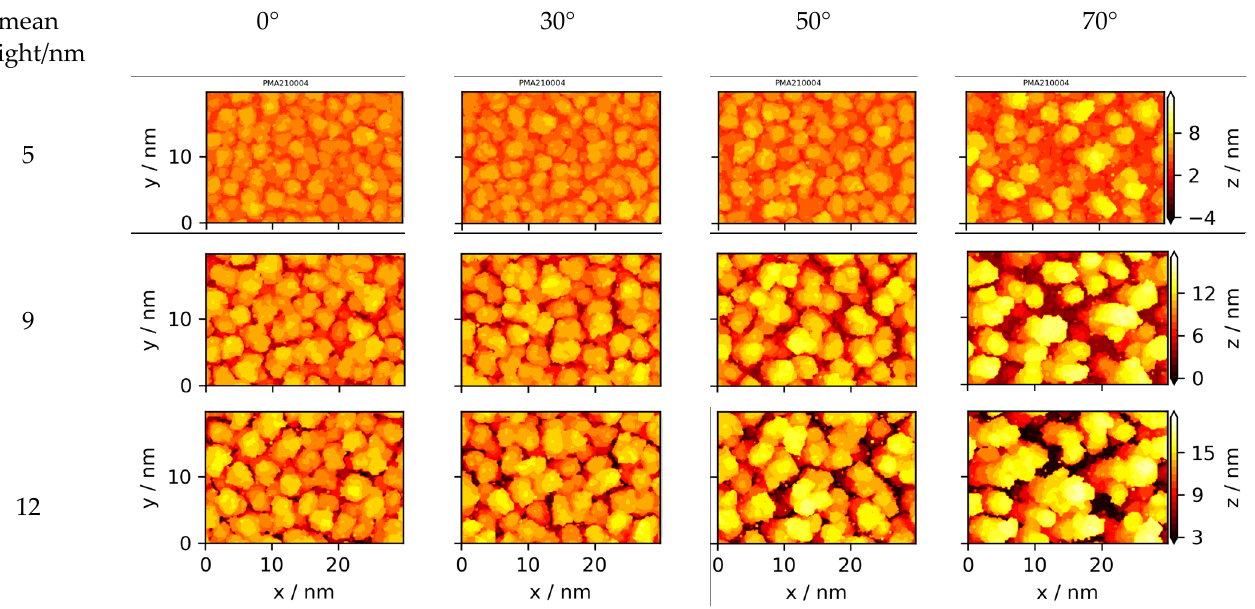
Figure 6. Images of the surface morphology for a substrate area of 30 × 20 nm 2 for different mean heights. The scale is shifted for different heights, but its range is kept the same to make all images comparable.